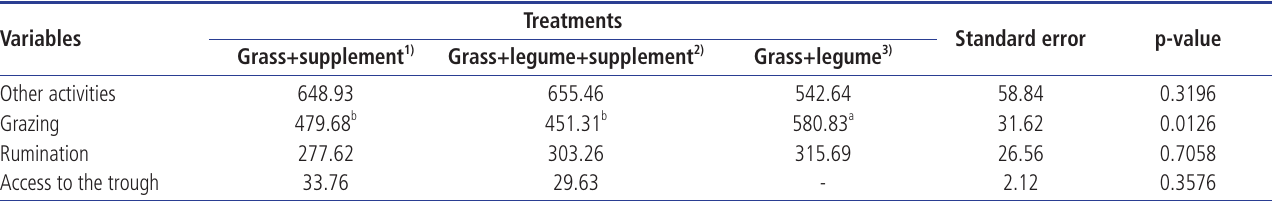
Table 4. Time (minutes) spent on behavioral activities by beef steers in oat and ryegrass pastures mixed or not with vetch and with or without energy supplementation, in the 24-hour period Variables Other activities